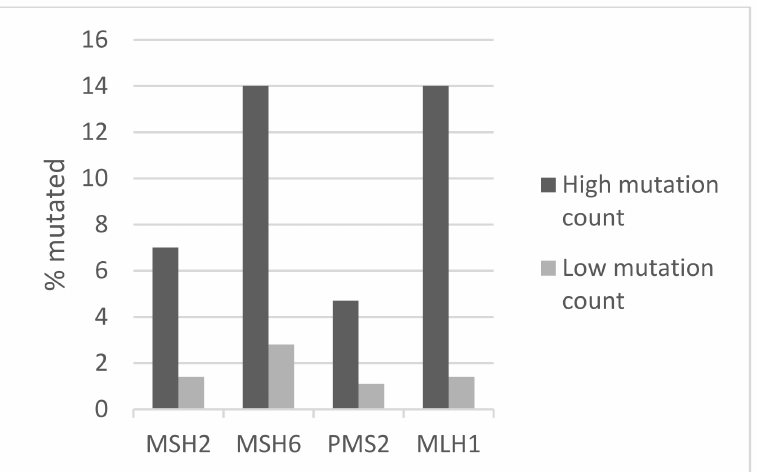
Figure 8. Prevalence of mutations in mismatch repair-related genes in ER-positive/HER2-negative breast cancers according to total mutation count (Fisher’s exact test for the comparison of total non-overlapping mutations in the 4 genes between the 2 groups p < 0.000). High mutation count group > 10 mutations/MB; low mutation count group ≤ 10 mutation/MB. Data are from the DFCI metastatic breast cancer study cohort.